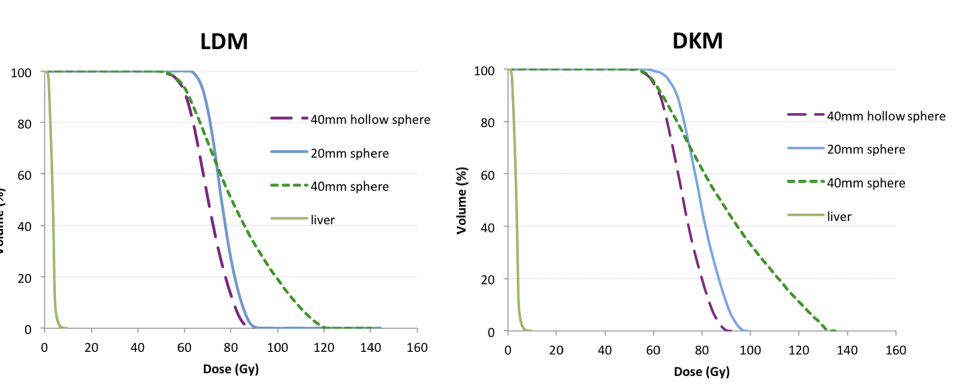
Figure 5. Cumulative dose-volume histograms for the three lesions and the entire liver volume of AbdoMan phantom using local energy deposition method (LDM, ( left )) and Dose kernel method (DKM, ( right